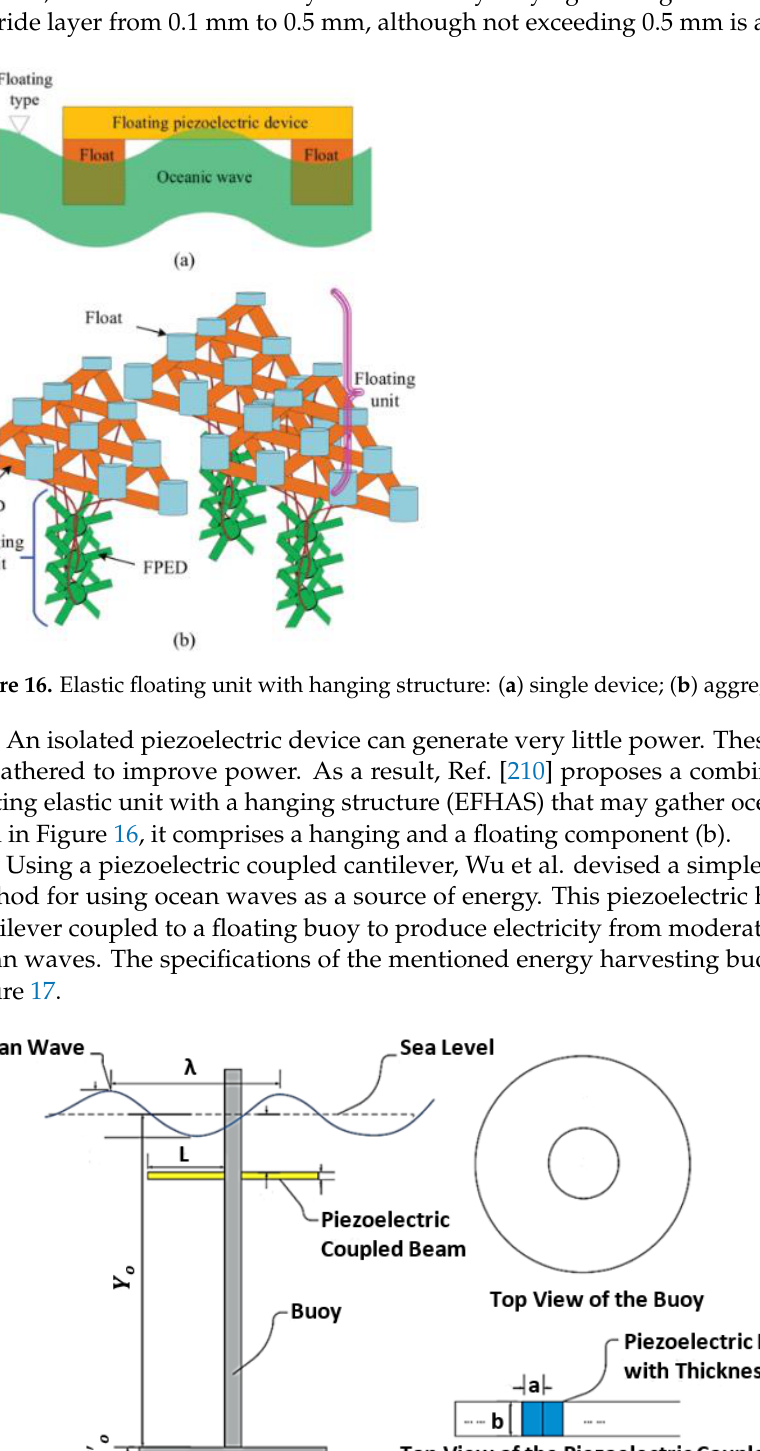
Figure 15. Experiments with a floating elastic device attached to a vertical marine cliff.